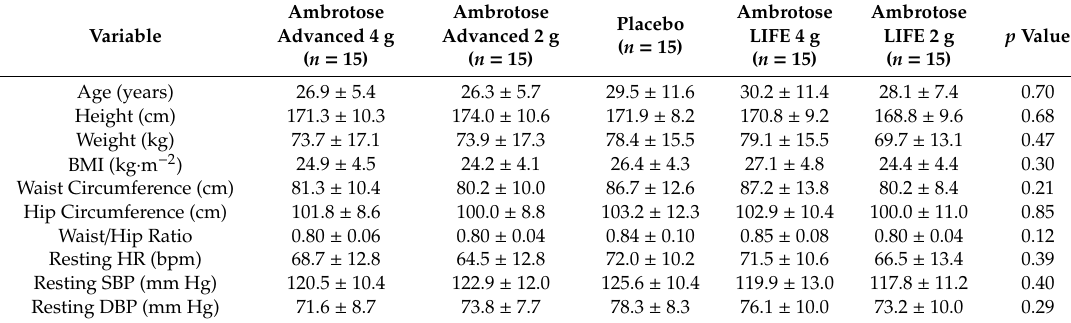
Table 1. Characteristics of 75 healthy men and